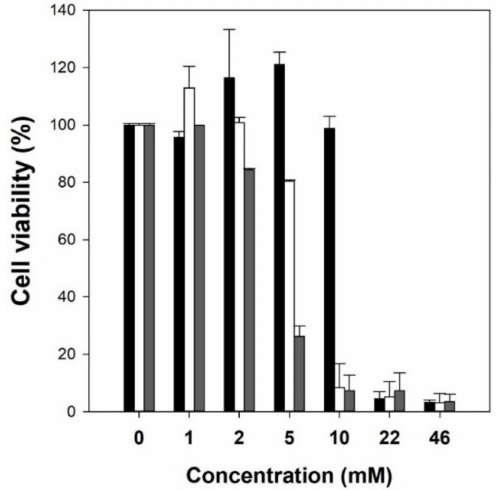
Figure 4. Cytotoxicity of natural mediators used for LMS. Black bars: acetosyringone, white bars: syringaldehyde, gray bars: